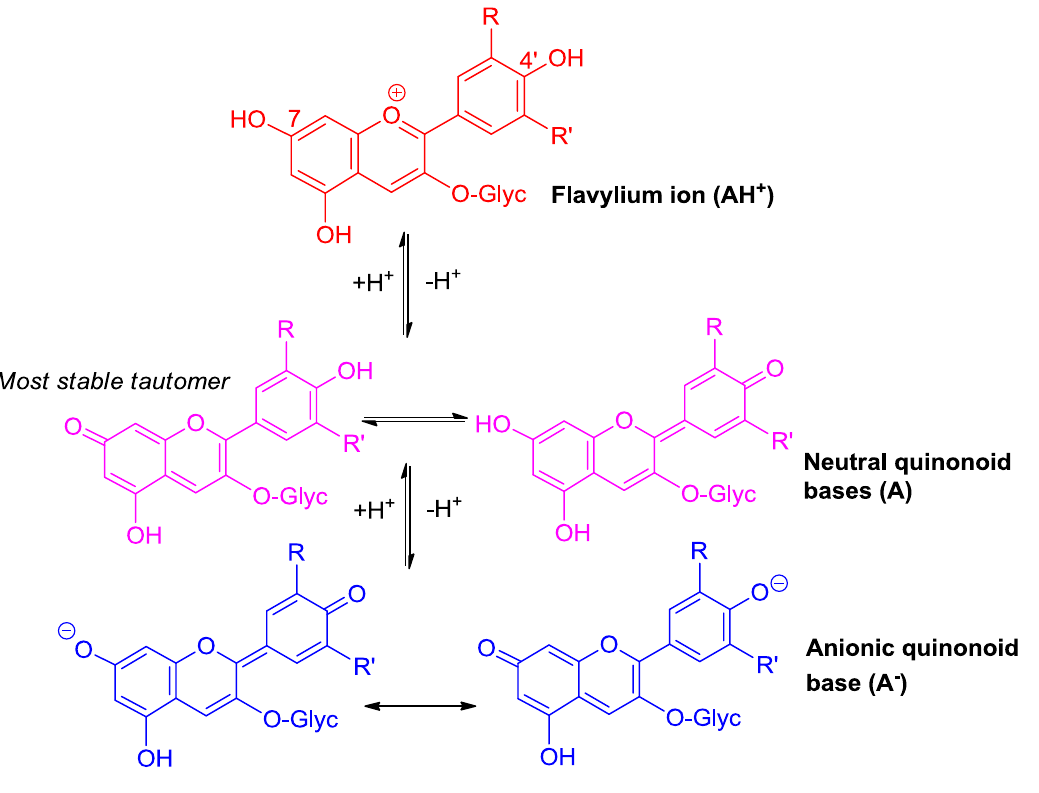
Figure 1. Flavylium ions are weak diacids.